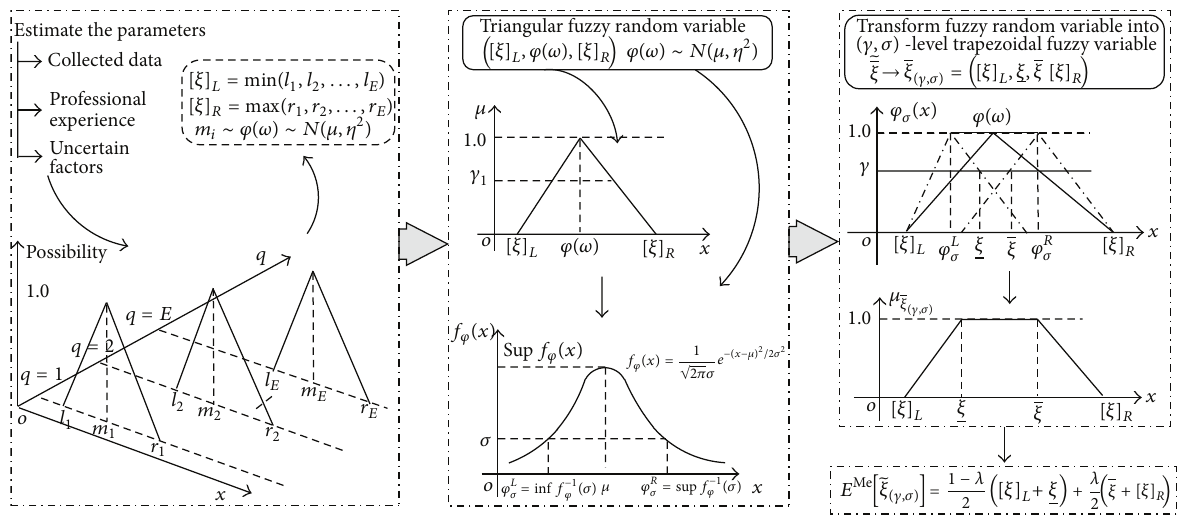
Figure 2: Transformation method of the fuzzy random